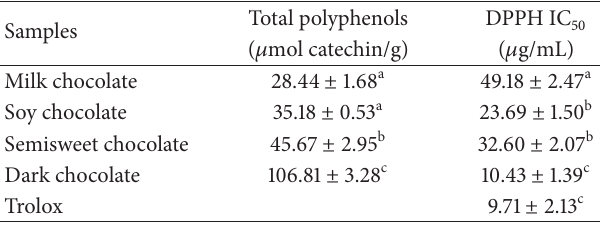
Table 1: Total polyphenols and DPPH radical-scavenging activity of different types of